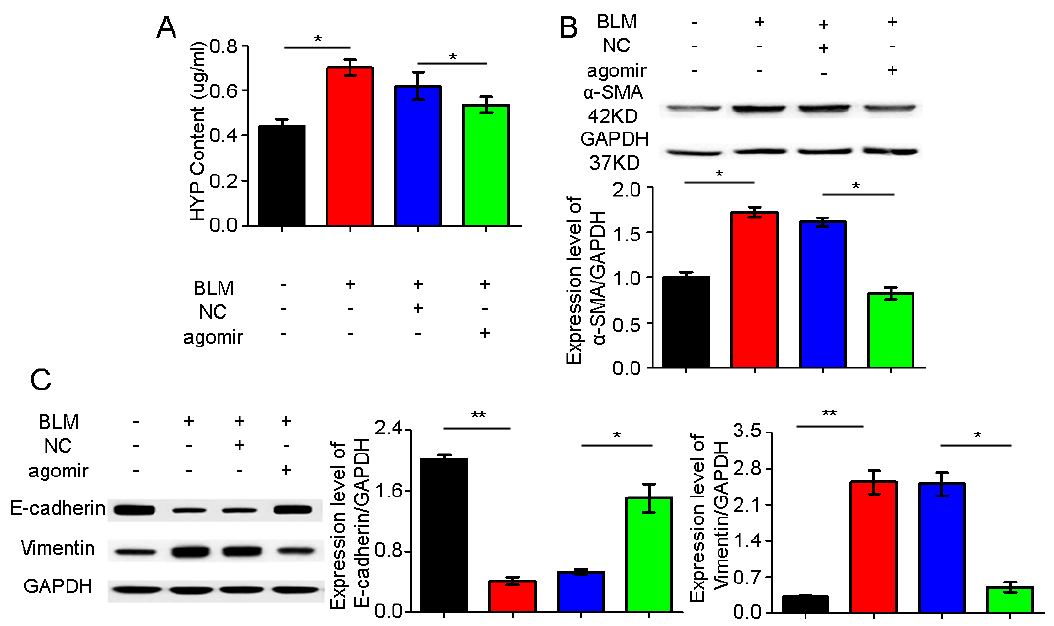
Figure 5. miR-30a agomir inhibited the indicators of pulmonary fibrosis in vivo. ( A ) miR-30a agomir could inhibit the HYP level; ( B ) miR-30a agomir could inhibit the a-SMA expression; ( C ) miR-30a agomir could promote the E-cad expression and inhibit the vimentin expression. +/ − Indicates with or without reagent respectively.Each bar represents the mean ± SD, n = 6, * p < 0.05, ** p < 0.01.